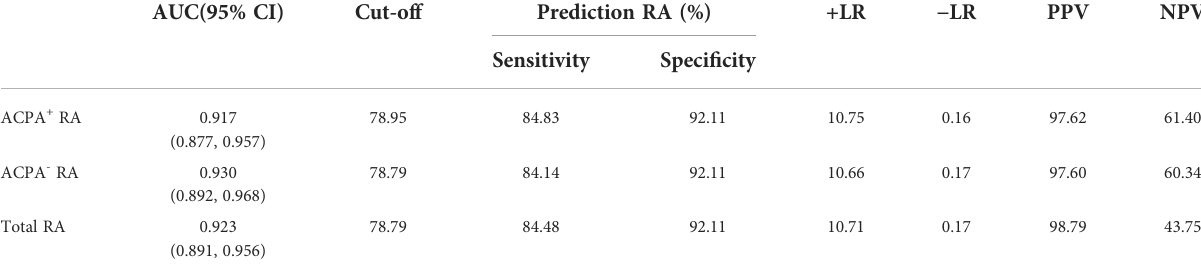
TABLE 2 Diagnostic accuracy of MMP-3 in RA patients. AUC(95% CI) Cut-off Prediction RA